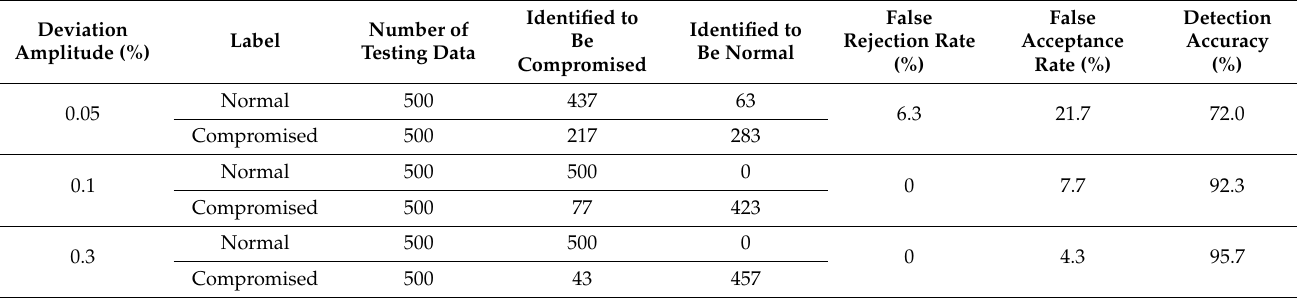
Table 4. Results of the proposed model for FDI attack detection in the IEEE bus-118 system. Deviation Amplitude